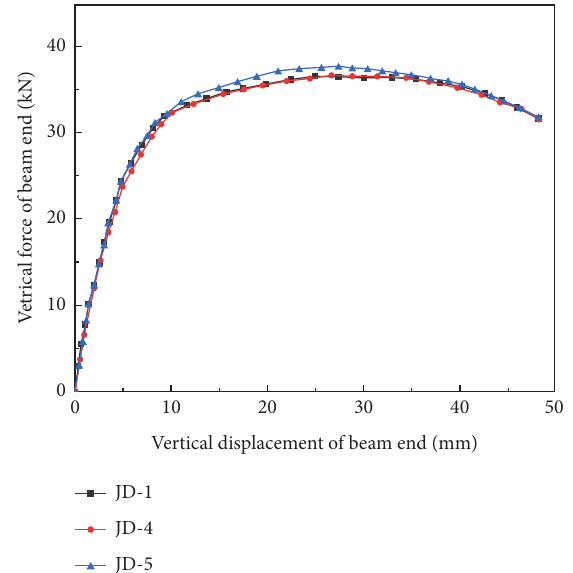
Figure 15: The skeleton curves of different grouted segment lengths.